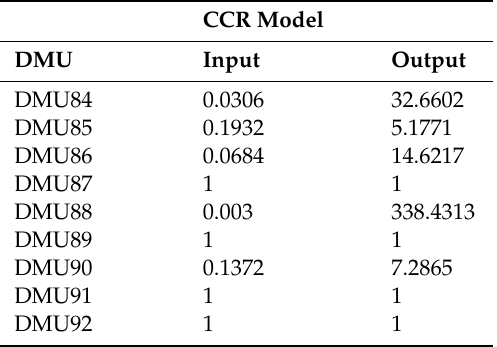
Table 6. CCR method for assessing the e ff ectiveness of manufacturers of rubber plastic products.